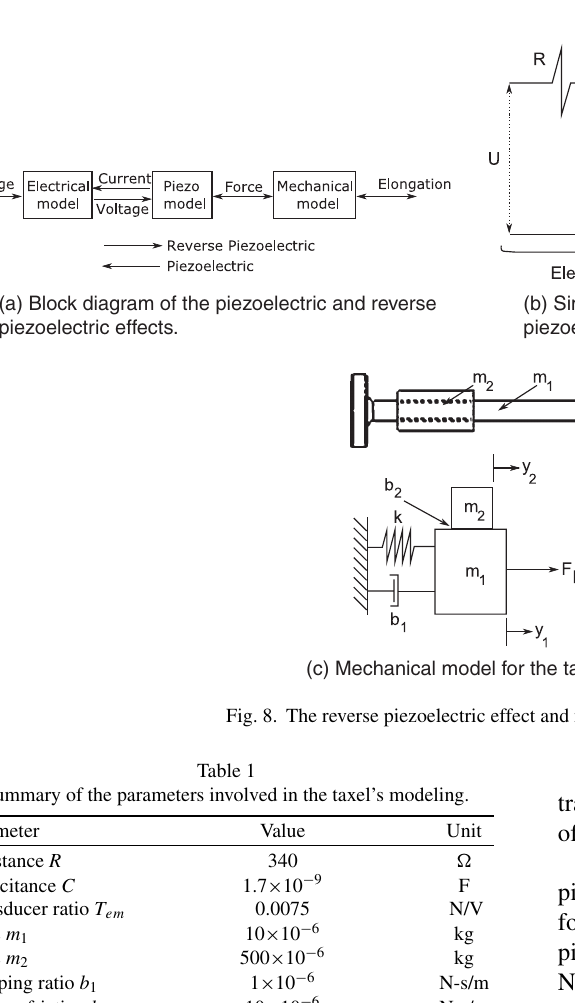
(b) Simplified electromechanical model for the reverse piezoelectric effect [7].